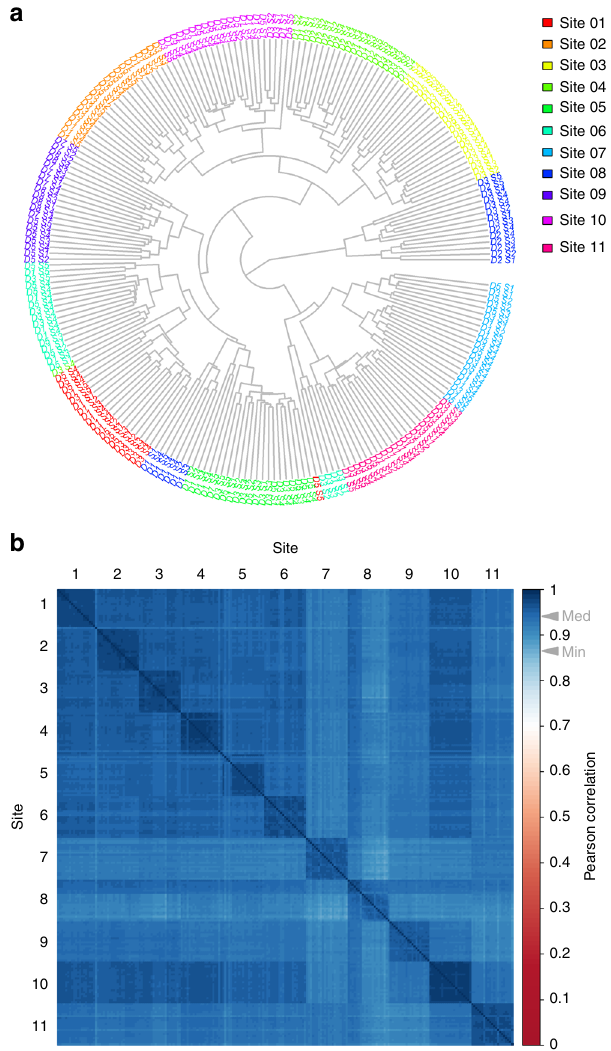
Fig. 6 Clustering and correlation of SWATH-MS quantitative proteomes. a The dendrogram for the 229 samples from all sites resulting from hierarchical clustering based on the log2 protein abundances generated from the SWATH-MS data is shown. The sites are color coded as per the legend. The “ D ” and “ S ” notation refers to the day and sample number respectively (Fig 1a). The samples primarily cluster by site of data acquisition whereas the day of data acquisition with one site is generally not clustered. b A correlation matrix showing Pearson coef fi cients between the 229 samples (all vs. all) is shown. The samples are ordered fi rst by site and then chronologically. The color-scale indicates the magnitude of the Pearson correlation coef fi cient and the gray arrowheads on the color-scale indicate the median and minimum Pearson correlation across all